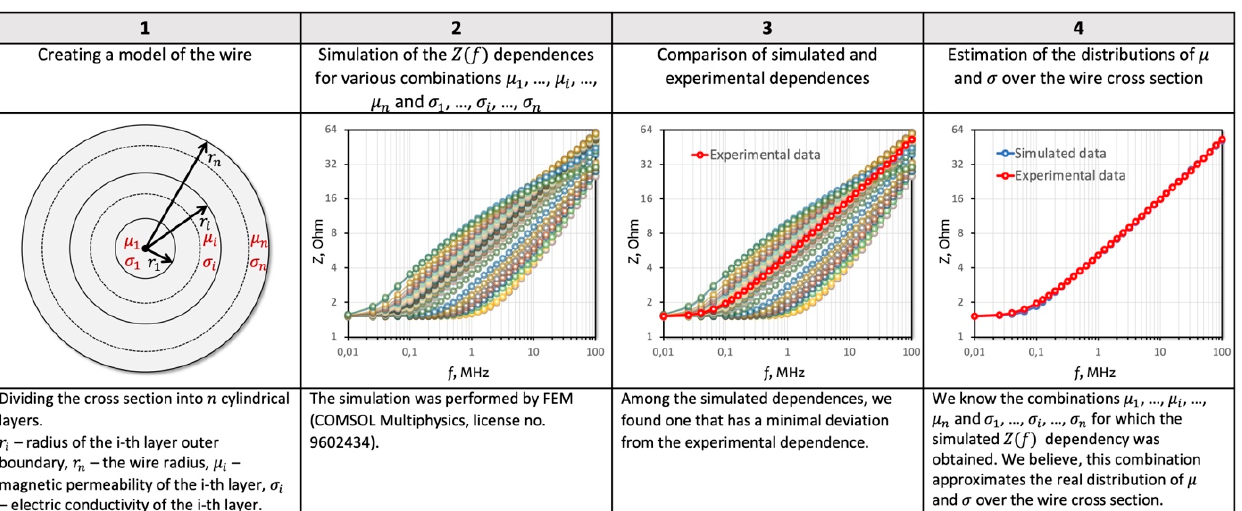
Figure 2. The composite wire images obtained by scanning electron microscopy ( a ) and X-ray fluo- rescence at wavelengths corresponding to Cu-K α ( b ), Fe-K α ( с ), Co-K α ( d ), and Ni-K α ( e ). The longitudinal magnetic hysteresis loop of the CuBe/FeCoNi composite wire has convexity and squareness coefficients close to 1 (Figure 3). Such a loop indicates that axial